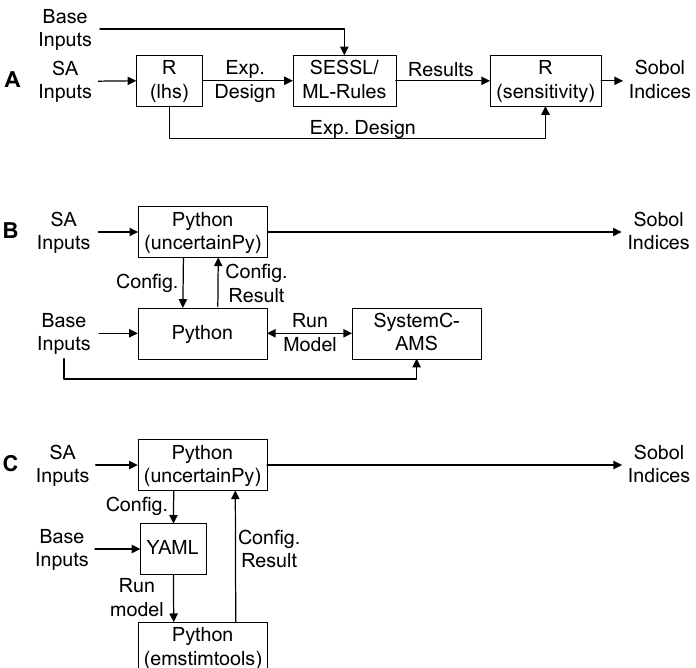
Figure 4. Schematic of the generated code for the three SA experiments for ( A ) the Wnt signaling model, ( B ) the battery model, and ( C ) the electric fields model. The experiments take the user-given base inputs and SA inputs and produce Sobol indices as